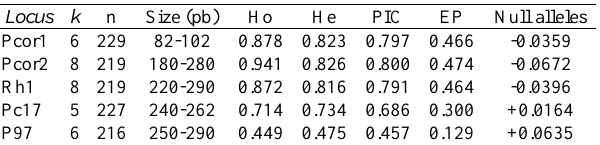
Table 3. Locus SSR, number of alleles ( k ), number of individuals successfully genotyped (n), range of observed alleles in pb (size), observed heterozygosity (Ho), expected heterozygosity (He), polymorphic information content (PIC), probabilities of exclusion (EP) and null alleles estimated by Cervus version 3.0 at a frequency >